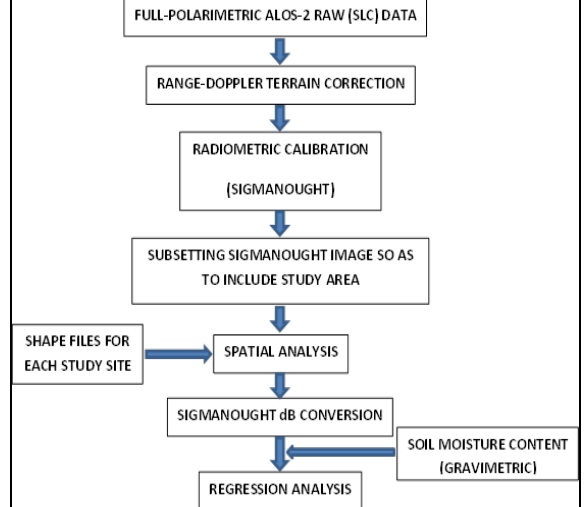
Figure 2. Workflow diagram of the